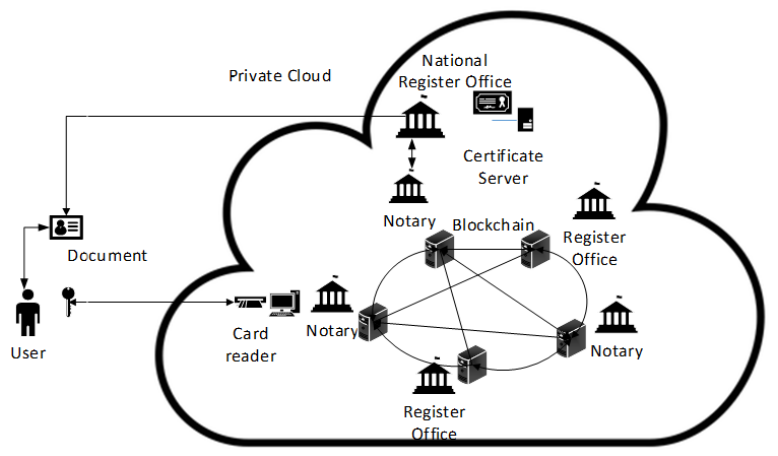
Figure 2. Proposed Blockchain architecture for the e-ID system